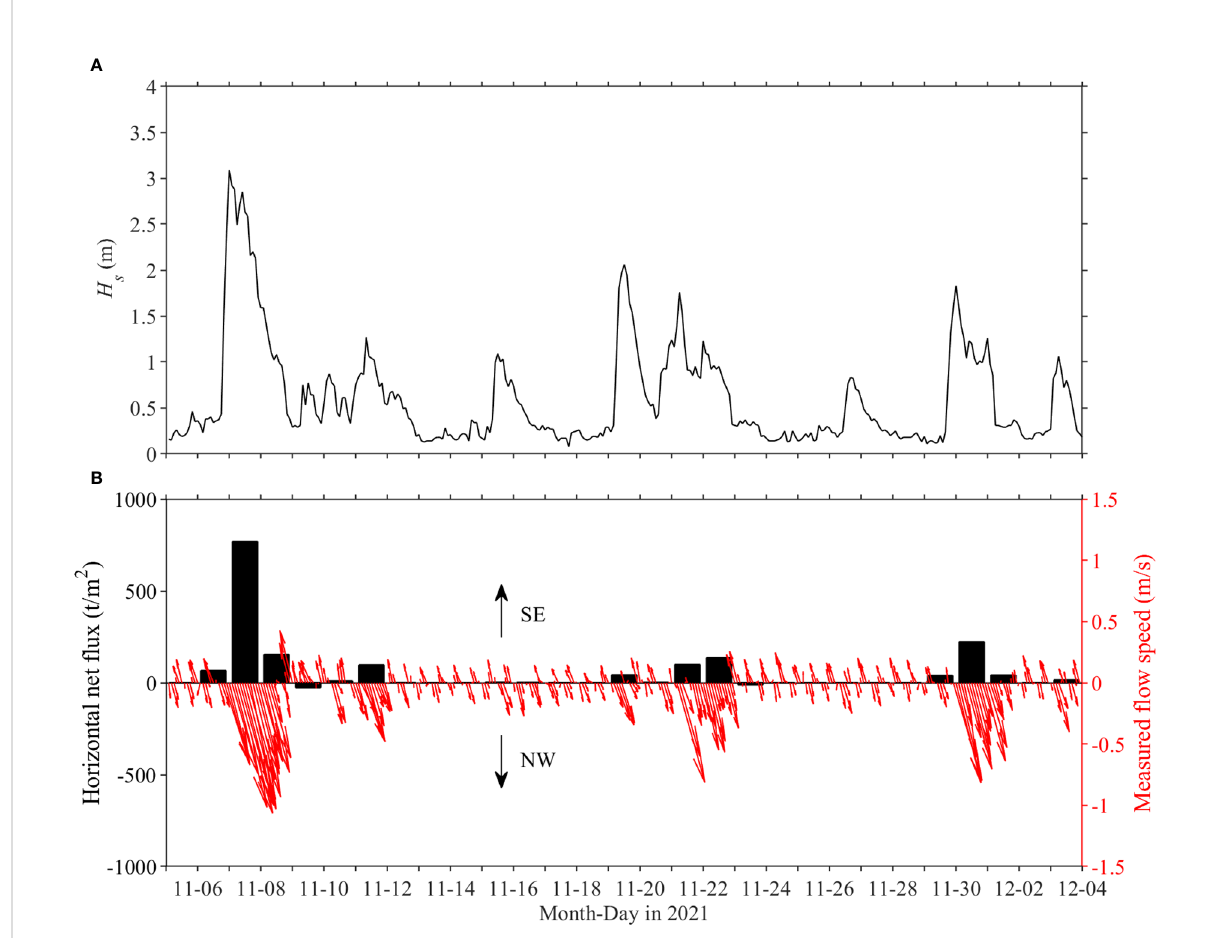
FIGURE 11 Time series of (A) signi fi cant wave heights Hs and (B) horizontal net fl uxes of sediments in the bottom boundary layer (black bands) and horizontal velocity vectors measured via acoustic doppler velocimetry (ADV) (red arrows). Black arrows indicate the direction of sediment transport, with “ SE ” indicating southeast and “ NW ” indicating